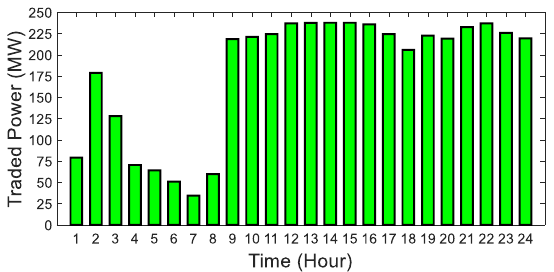
Figure 13. Traded power in the wholesale electricity market.